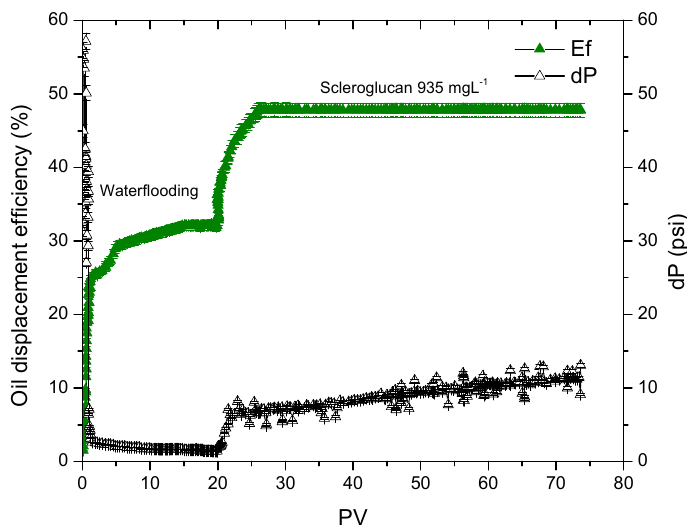
Figure 4. Oil displacement efficiency and differential pressure after waterflooding (3800 mgL − 1 TDS) and biopolymer flooding (SG, 935 mgL − 1 ). The porous media is composed of Berea Sandstone with porosity (ø) and permeability ( k ) of 22% and 585 mD, respectively. The dimensions of the plug are 6.07 cm in length and 3.73 cm in diameter. Overburden pressure: 1300 psi, Backpressure: 300 psi, and Temperature: 212